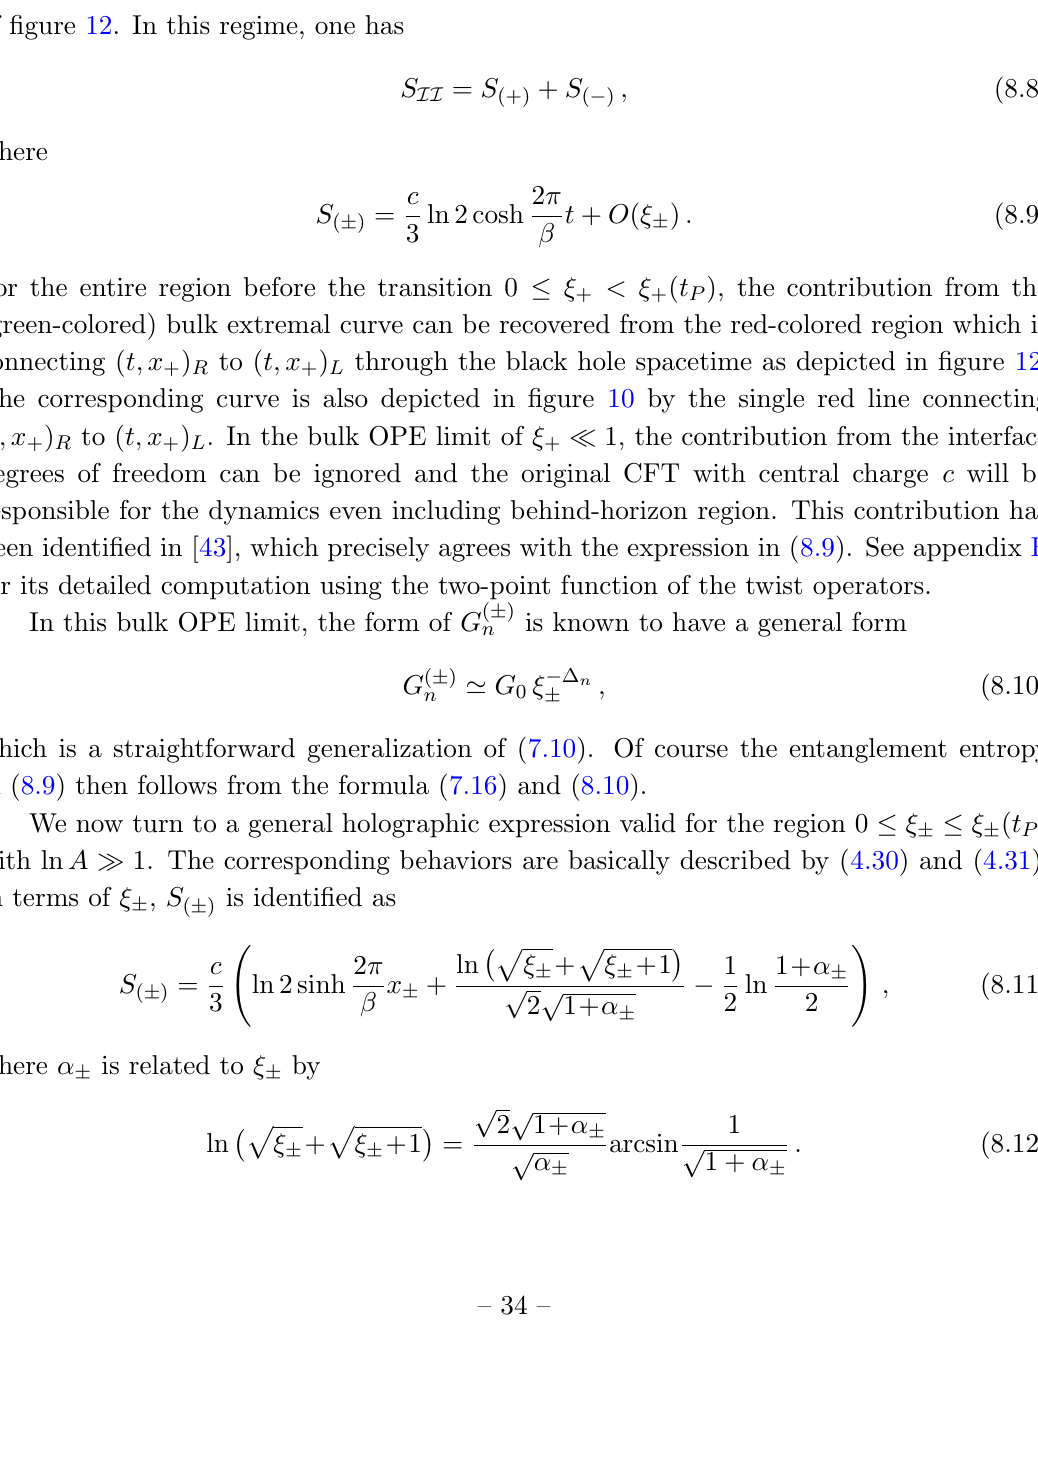
Figure 12 . The 3d bulk picture of constant (cid:28) slice is given for 0 draw the RL extremal curve with (cid:24) + touching the (cid:22) = (cid:22) I